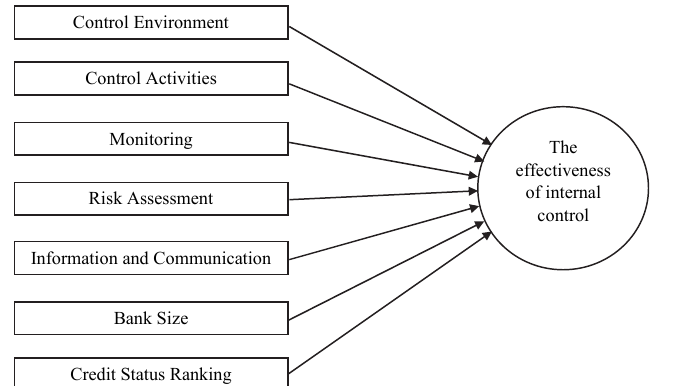
Fig. 1. Research model: Factors affecting the effectiveness of internal control at Vietnamese joint stock commercial banks (Source: Kaplan (2008), Vu (2016) ) 4.1.2. The content describes variables, measurement methods and research